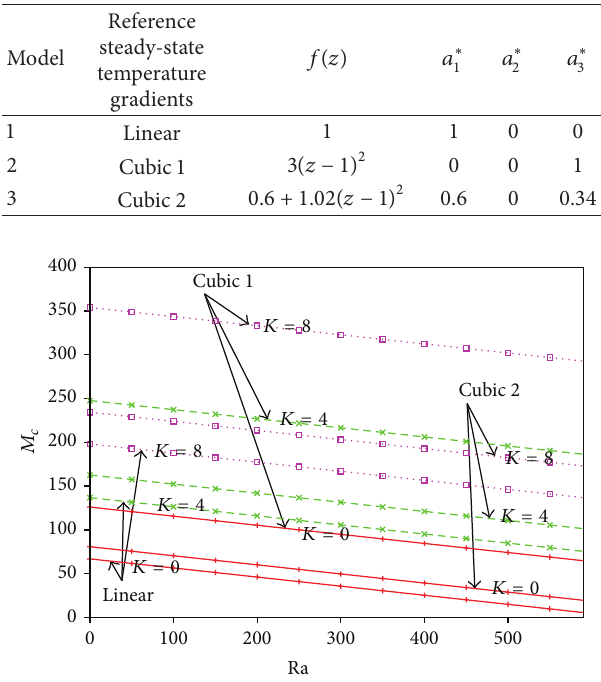
Figure 1: Plot of 𝑀 𝑐 versus Ra for different values of 𝐾 = 0 , 𝐾 = 2 , and 𝐾 = 4